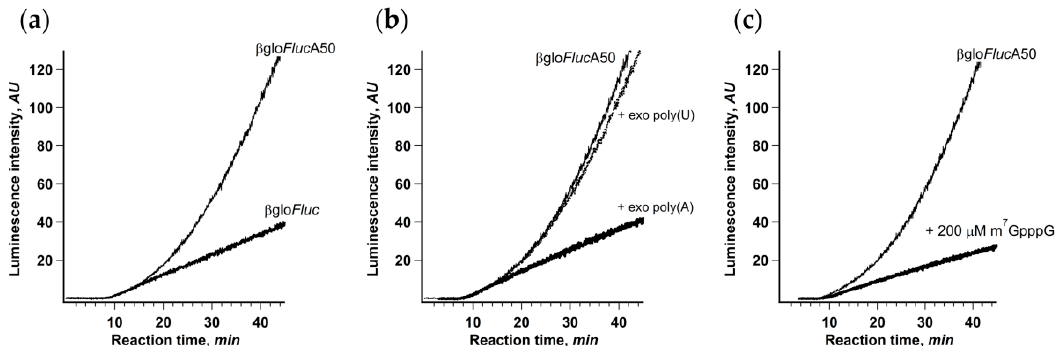
Figure 3. Integrity of mRNA cap-to-tail interactions is crucial for the acceleration of translation. ( a ) Continuous in situ monitoring of the translation of mRNA with ( β gloFlucA50, thin line) and without ( β gloFluc, bold line) 3’-A50 sequence in a Krebs-2 cell-free system; ( b ) addition of high-molecular weight exogenous poly(A) (to 25 µ M of adenylic residues) to the Krebs-2 cell-free system translating β gloFlucA50 mRNA; ( c ) addition of cap analog (m 7 GpppG) to the same translation system.